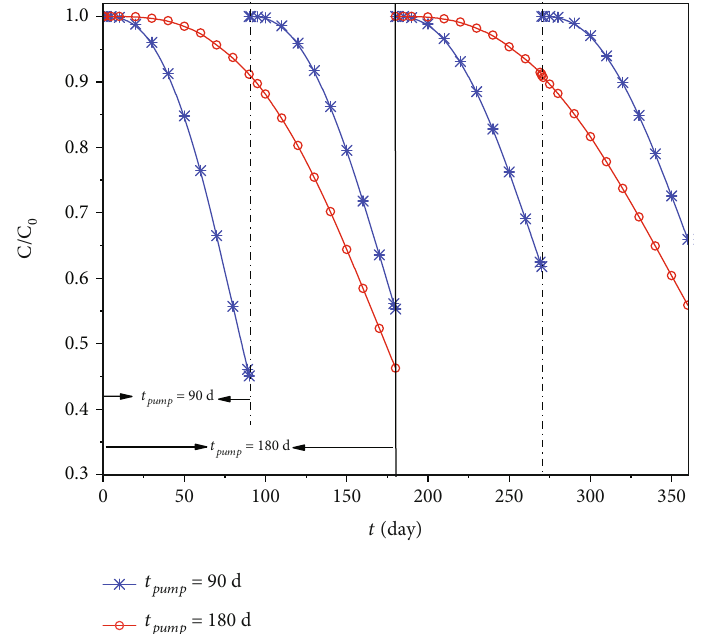
Figure 9: BTCs inside the well with di ff erent pumping frequencies without regional groundwater velocity in the pumping